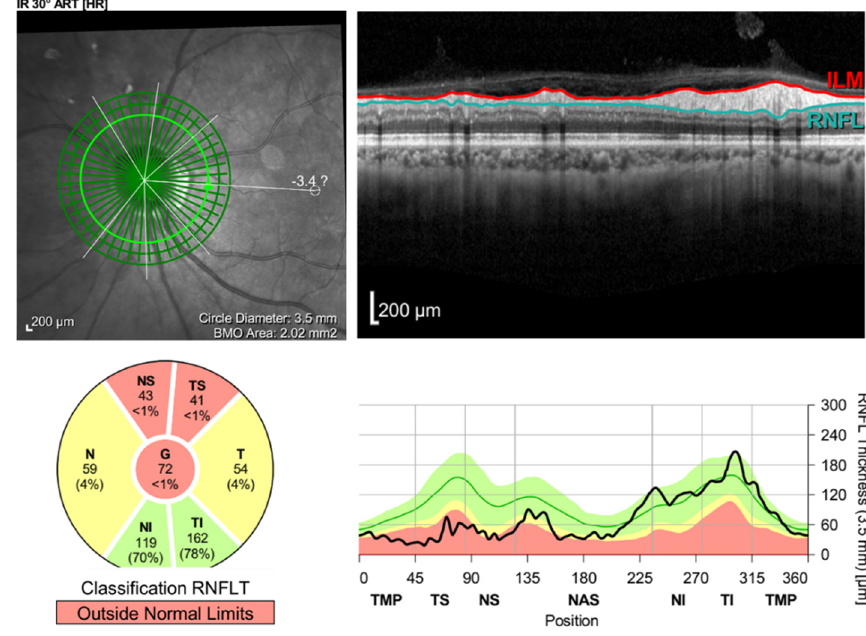
Figure 4. Retinal nerve fiber layer (RNFL) analysis of the left eye revealed RNFL loss after resolution of the optic disc edema.